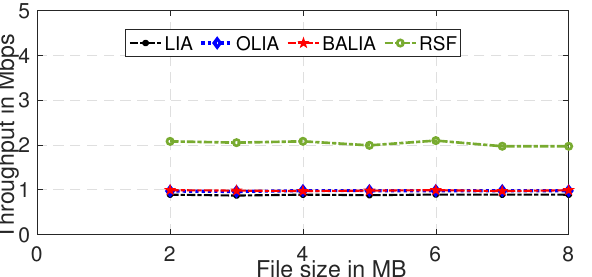
Figure 3. Throughput results for different file sizes in Scenario 2: homogeneous paths with 10 Mbps bandwidth, 150 ms delay, and 2% random packet loss.